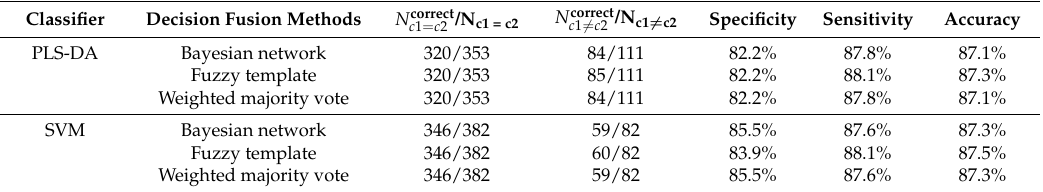
Table 3. Classification results of prediction set obtained by fusing the feature level classification using decision fusion